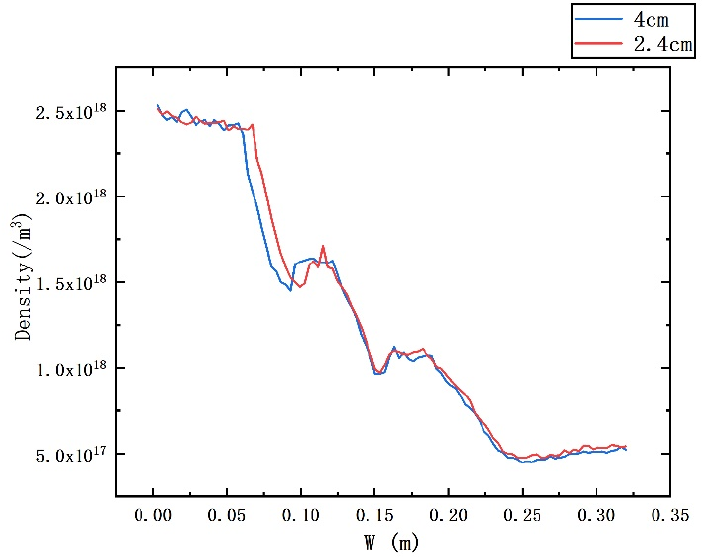
Figure 11. Gas molecules’ density distribution along the inlet direction when L 2 = 2.4 cm and 4 cm. According to the actual situation, the adaptive range of L 3 is 3.5–5.5 cm, and thus, we analyzed the influence of L 3 at 3.6, 4, 4.4, 4.8, and 5.2 cm on the transmission probability, as shown in Figure 12.